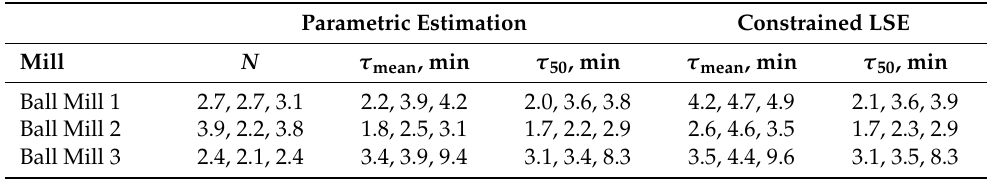
Table 2. Mean and median residence times obtained from the parametric deconvolution and the constrained LSE. The number of equivalent perfect mixers in series is also presented. Information sorted from the lowest to the highest τ 50 for the three